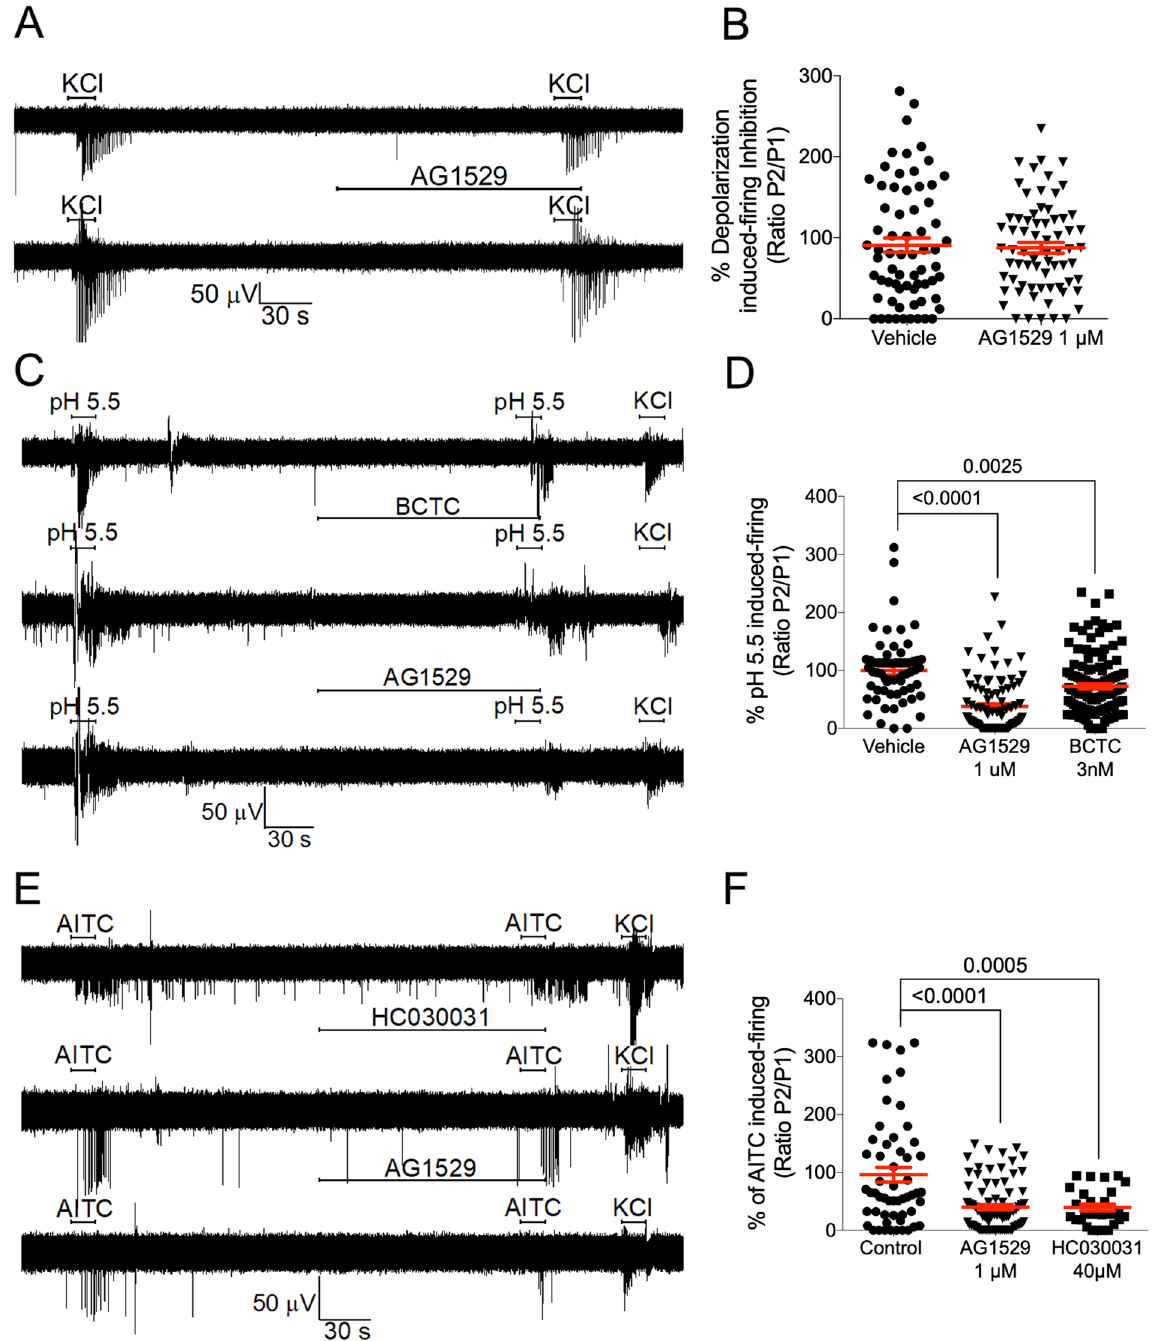
Figure 7. AG1529 effect on voltage, pH and AITC-evoked nociceptor excitability. ( A ) Representative MEA recordings of extracellular K + (40 mM KCl)-induced nociceptor firing of APs in the absence and presence of 1 µM AG1529, applied 2 min before the second extracellular K + pulse. ( B ) Normalized extracellular K + -induced neuronal firing of the second pulse in the absence and presence of AG1529. ( C ) Representative MEA recordings of acid pH (5.5)-induced nociceptor firing of APs in the absence and presence of 1 µM AG1529, applied 2 min before the second acidic stimulus. ( D ) Normalized pH-induced neuronal firing of the second pulse in the absence and presence of AG1529. Data were analysed using the One-Way Anova (F(2,275) = 28.15, p < 0.0001). ( E ) Representative MEA recordings of AITC (50 µM)-induced nociceptor firing of APs in the absence and presence of 1 µM AG1529, applied 2 min before the second AITC pulse. ( F ) Normalized AITC-induced neuronal firing of the second pulse in the absence and presence of 1 µM AG1529. Data were analysed using the One-Way Anova F(2,163) = 14.73, p < 0.0001 for panel ( D ) followed by the Bonferroni´s post hoc test, p-values for statistical difference are indicated. N (independent experiments) = 3, number of electrodes = 50–130 per